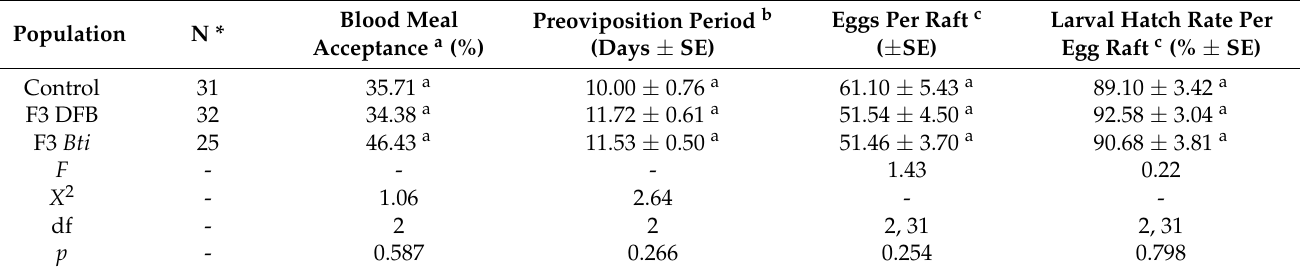
Table 5. Reproductive parameters of post-overwintering Cx. pipiens f. pipiens females. Females originated from populations that were either selected against diflubenzuron (DFB) and Bti for three successive generations or not (control). In each column, different letters indicate significant differences ( p < 0.05).